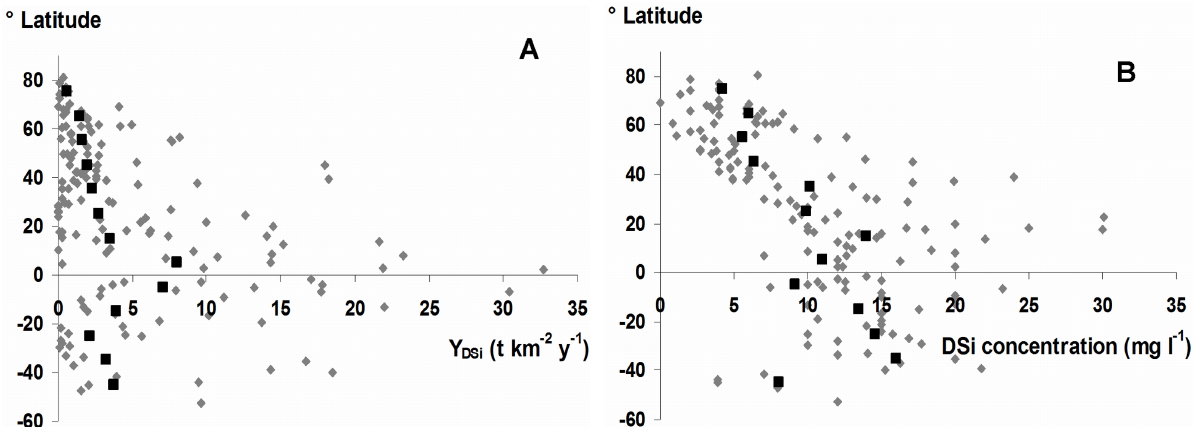
Fig. 2. Latitudinal distribution of dissolved silica inputs to coastal zones (at barycentre of the 140 COSCATs). (A): Y DSi in tSiO 2 km − 2 y − 1 , (B): DSi concentration in mgSiO 2 l − 1 . Grey dots: individual COSCATs, black dots: averages per 10 ◦ latitudinal